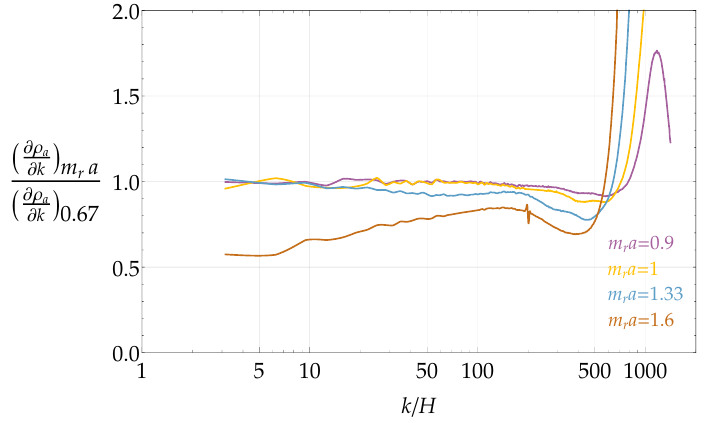
Figure 15 . Axion spectrum at log( m r =H f ) = 6 for di(cid:11)erent choices of the step-size m r a , normalised to the same quantities calculated with the (cid:12)nest lattice spacing m r a = 0 : 67. The other unphysical parameters are (cid:12)xed to a (cid:28) =a c = 1 = 3 and H f L f =